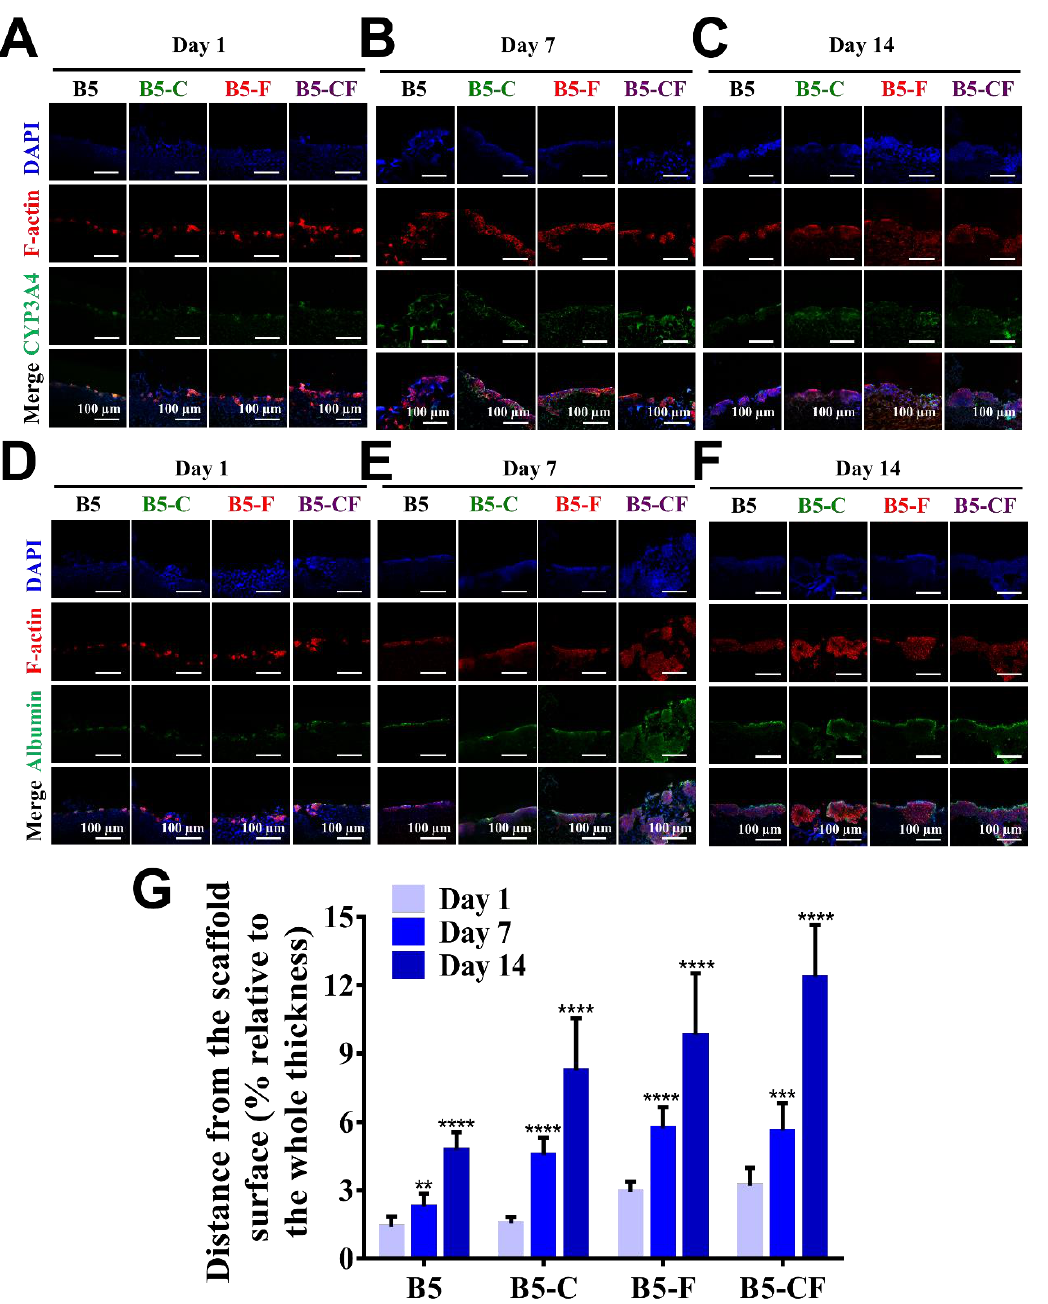
Figure 7. Evaluation of liver-specific functions and cellular infiltration of HepG2 cell constructs in cross-sections of 3D BSAMA cryogels at day 1, day 7, and day 14. ( A – C ) Confocal microscopic images of CYP3A4 immunostaining. Blue: nucleus; red: F-actin; green: CYP3A4. ( D – F ) Confocal microscopic images of albumin immunostaining. Blue: nucleus; red: F-actin; green: albumin. Scale bar: 100 µ m. ( G ) Distance of the cell migration. ( n = 3, **: p < 0.01, ***: p < 0.005, ****: p < 0.001), compared to the same cryogel type at day 1.